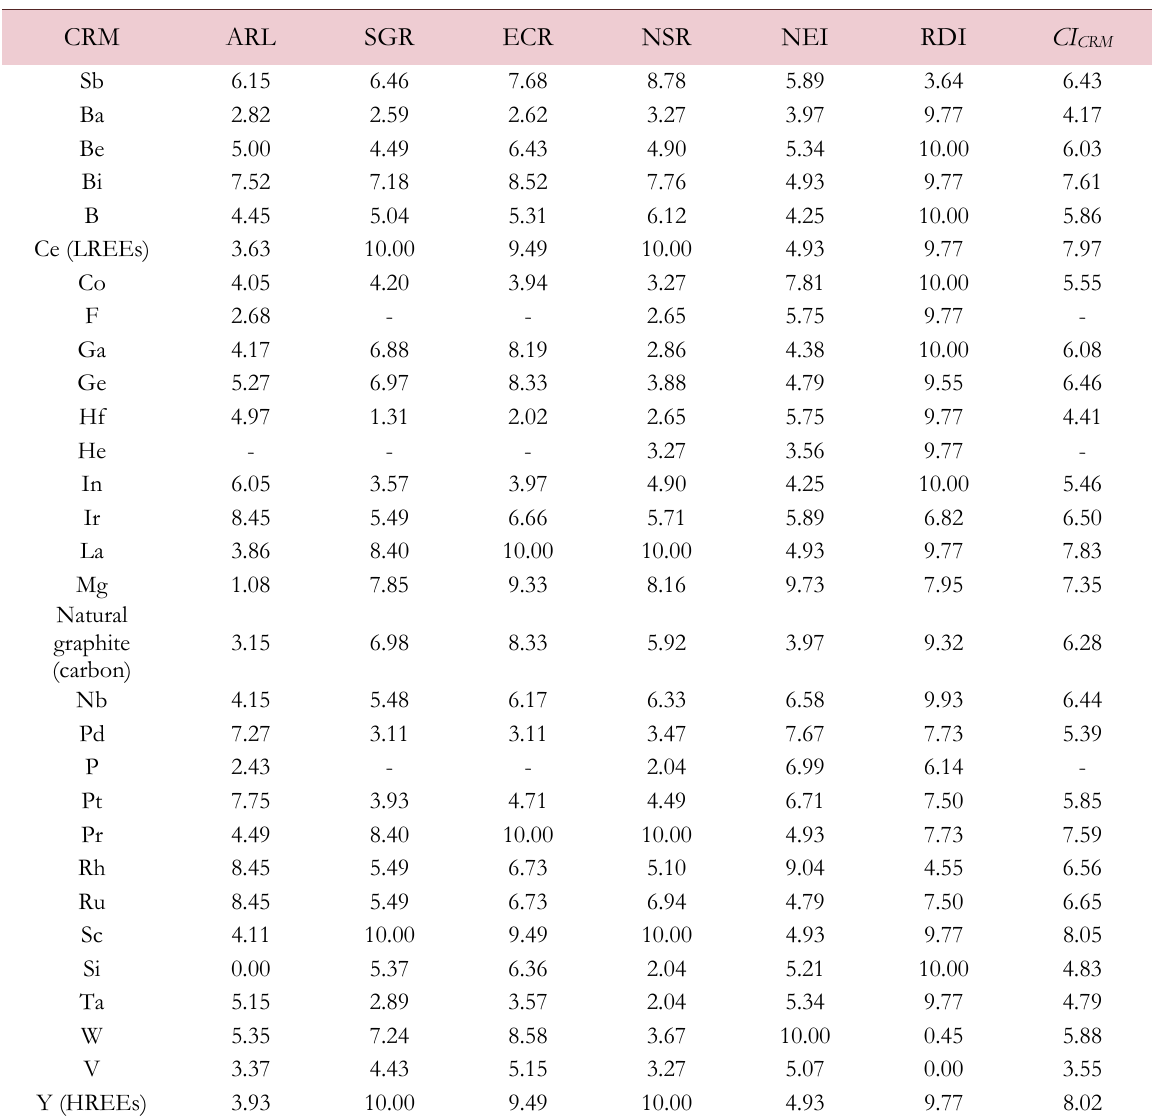
Table 1: Criticality grade of different CRMs measured by the RM Criticality Indicator (k = 1 for all the